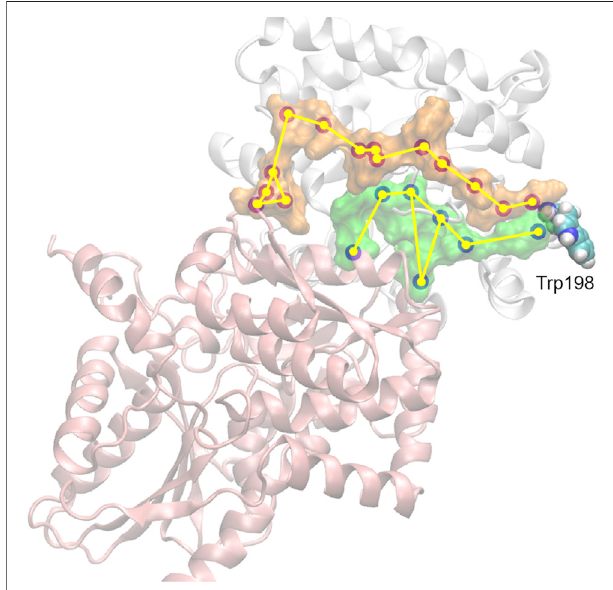
FIGURE 5 | Propagation of interaction changes induced by the A198W substitution were examined in two directions leading to the α TS (white) — β TS (pink) interface. α C of residues with affected conformation are traced, based on pair-wise force distribution analysis, from the substitution site as follows: in orange – α Asn194, α Leu193, α Leu191, α Ala189, α Arg188, α Glu186, α Ala185, α Ser235, α Lys239, α Glu242, α Asn66, α Gln65, β Ser161, β Gly162; in green – α His195, α Pro156, β Ile20, α Leu177, α Phe212, α Thr183, β